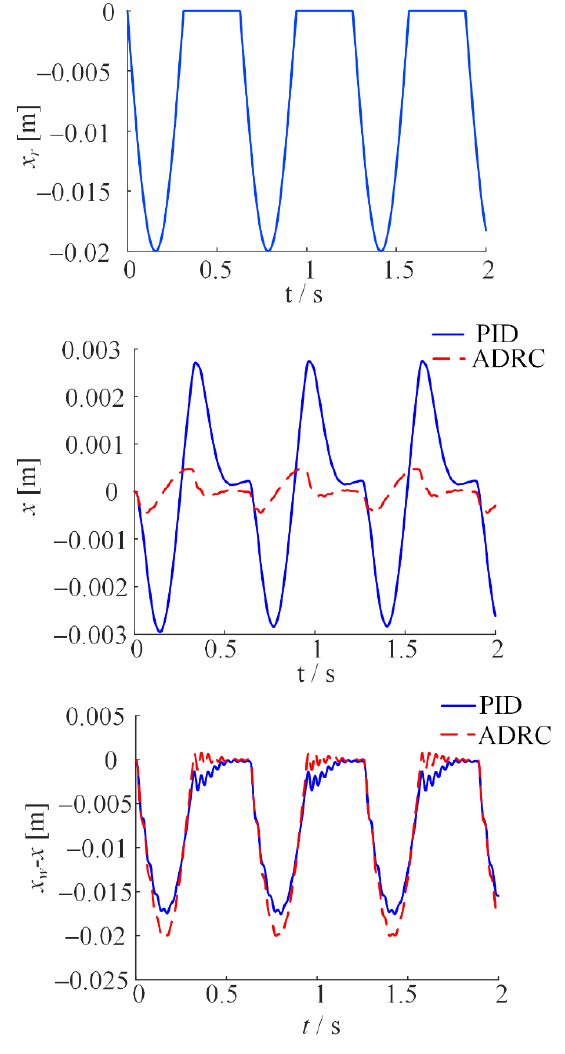
Figure 6. Performance of the ADRC scheme and the PID controller under half sine road excitation.